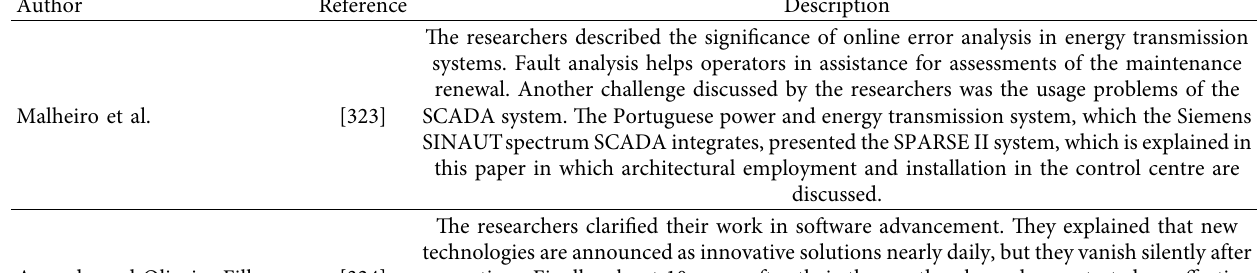
Table 12: Researcher’s contributions to the energy management system in smart